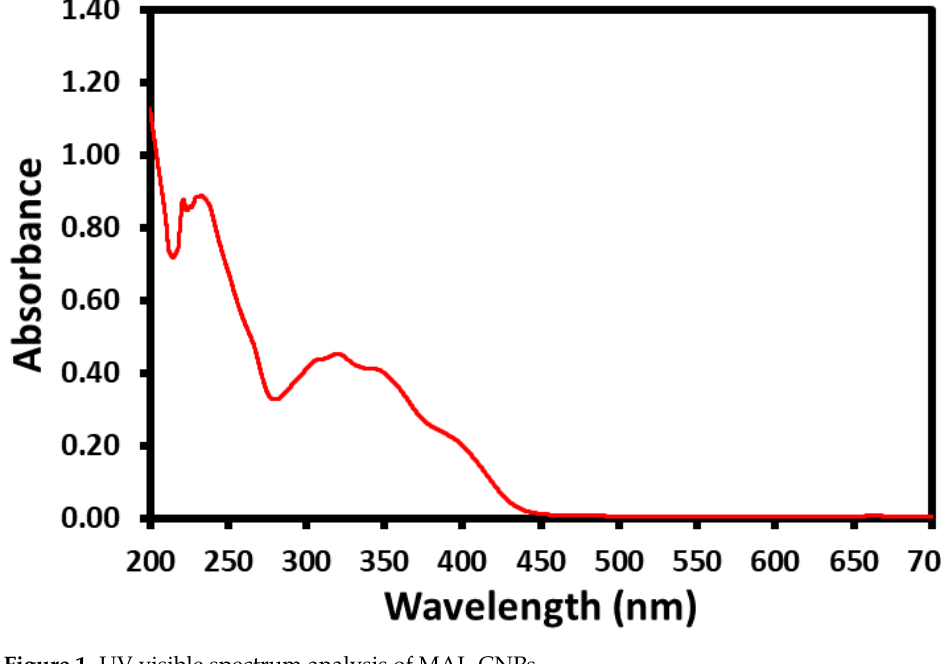
Figure 1. UV-visible spectrum analysis of MAL-CNPs.